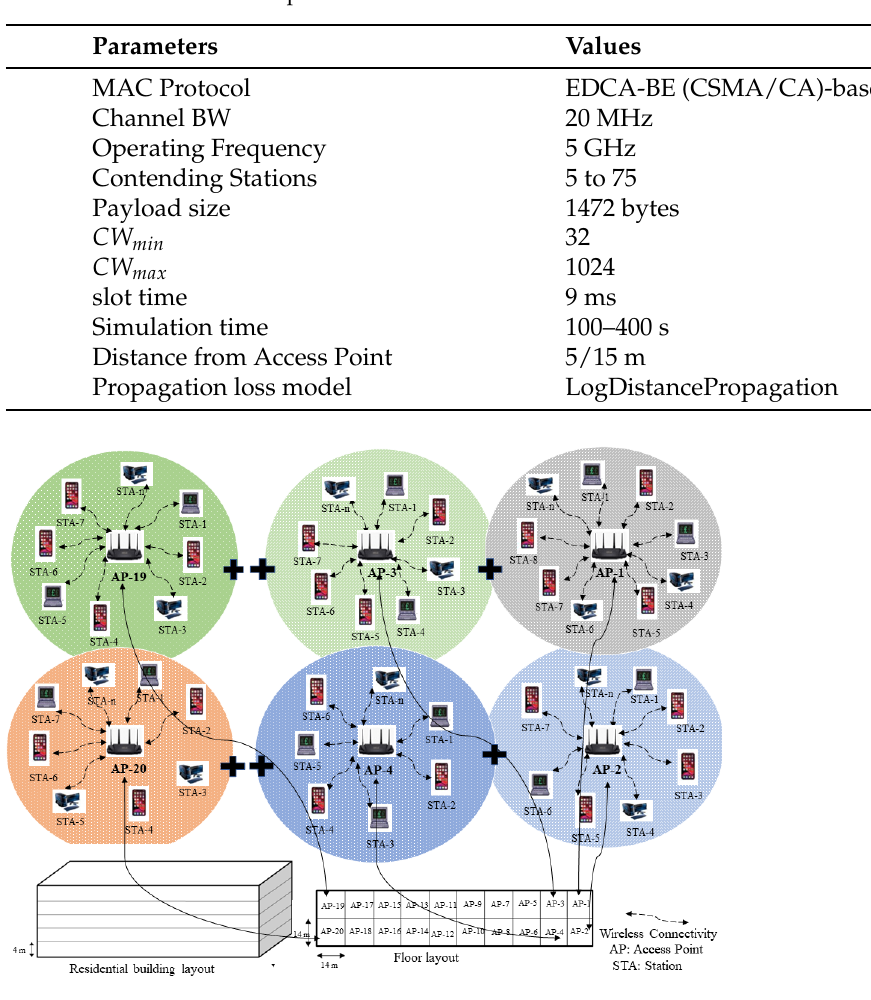
Figure 8. Multiple AP topology for a residential